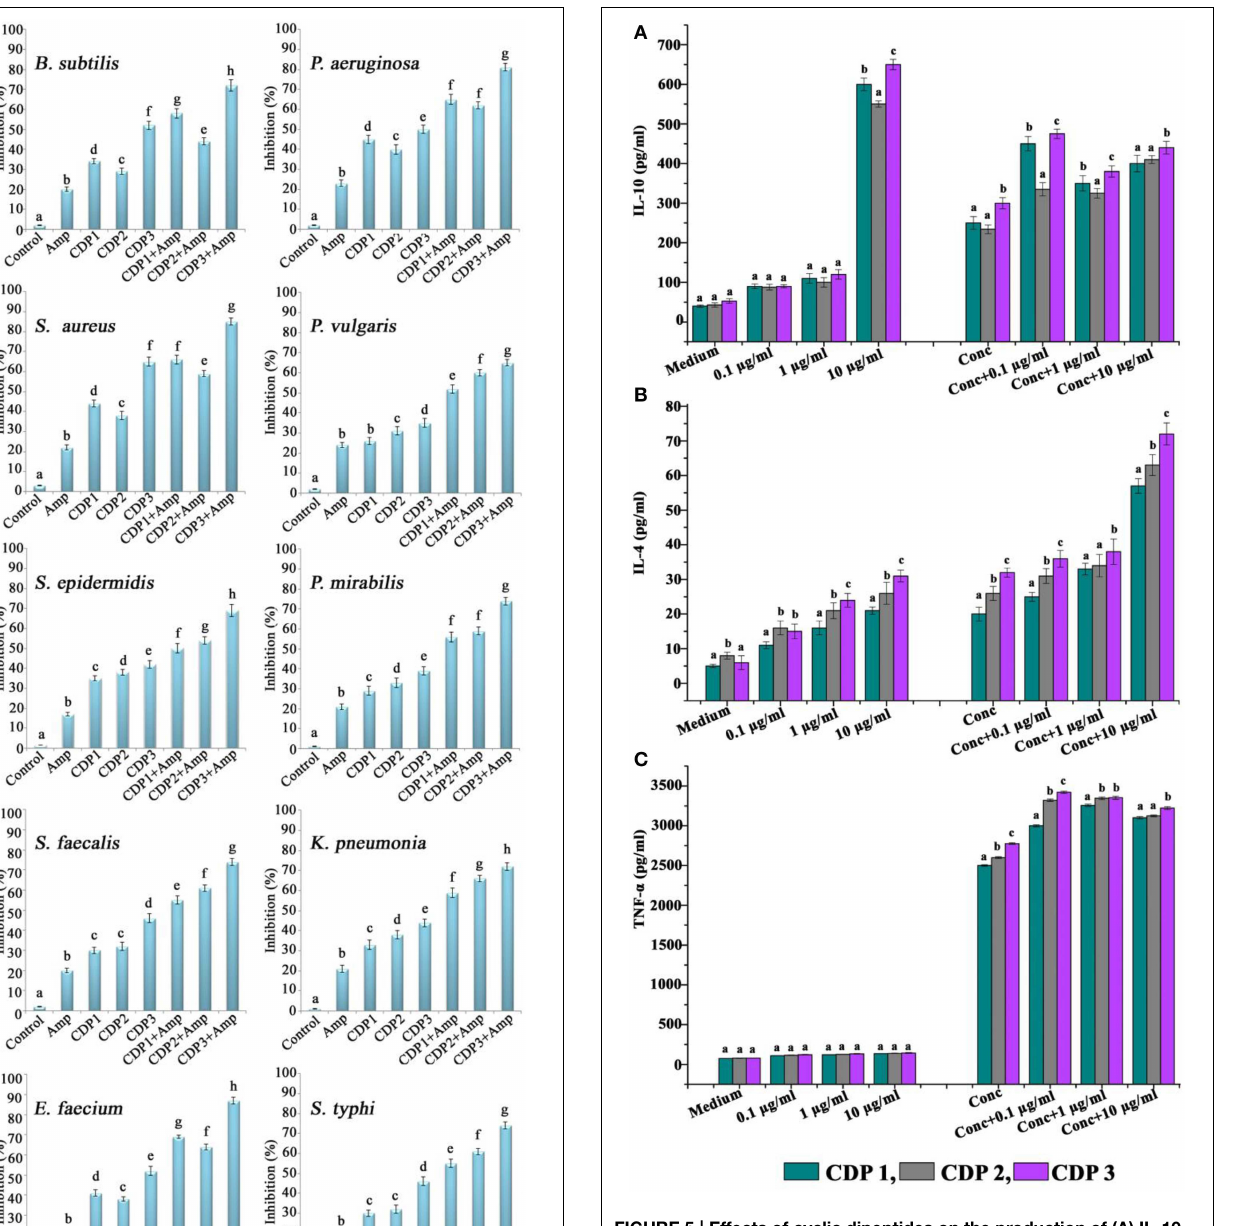
FIGURE 5 | Effects of cyclic dipeptides on the production of (A) IL-10, (B) IL-4, and (C) IFN- α by unstimulated and concanavalin A stimulated human peripheral blood mononuclear cells. Error bars indicate the standard deviations of three measurements. Different letters in the superscript were significantly different according to Duncan’s multiple range test ( p < 0 . 05